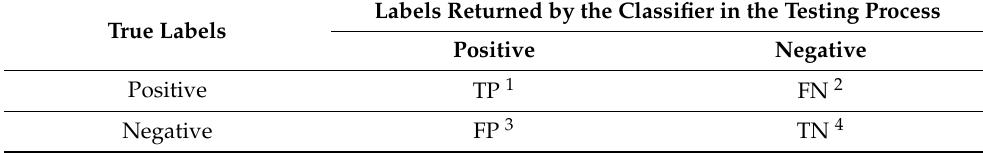
Table 3. Four statistical numbers of predicting results. True